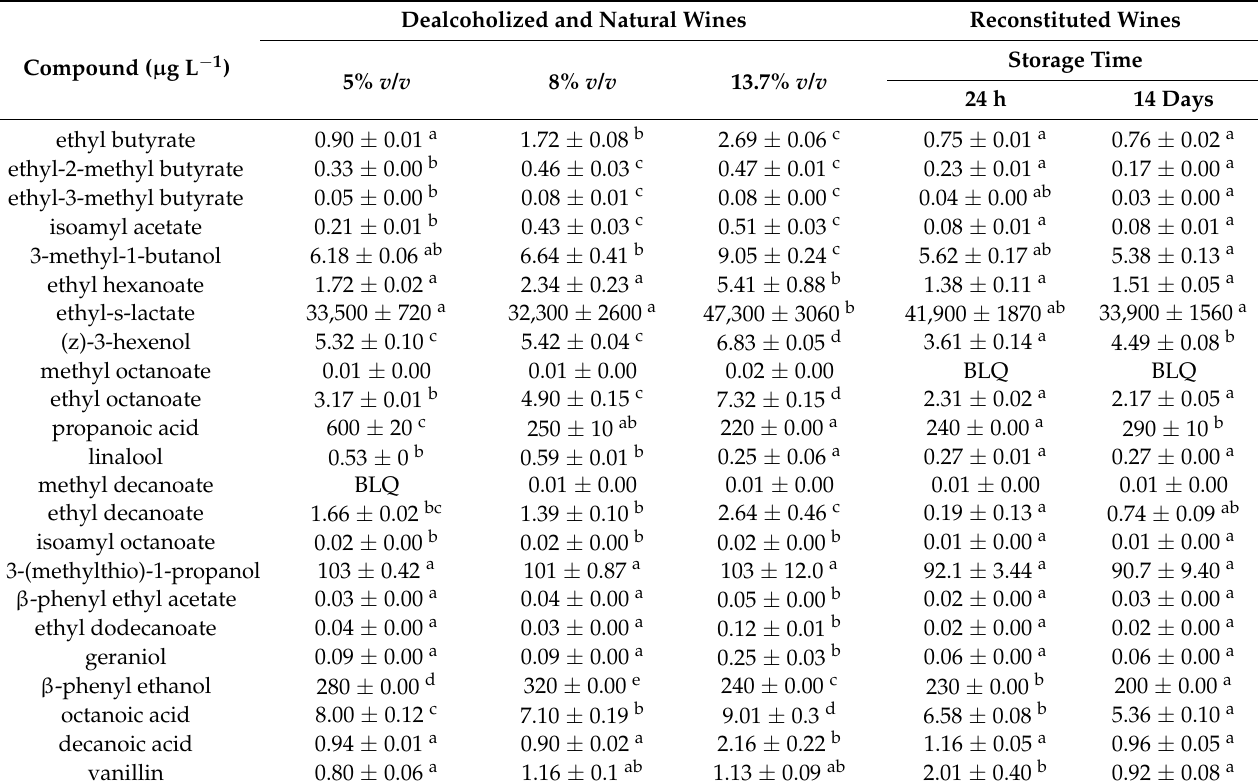
Table 3. The changes in the headspace concentration of volatile compounds in Shiraz